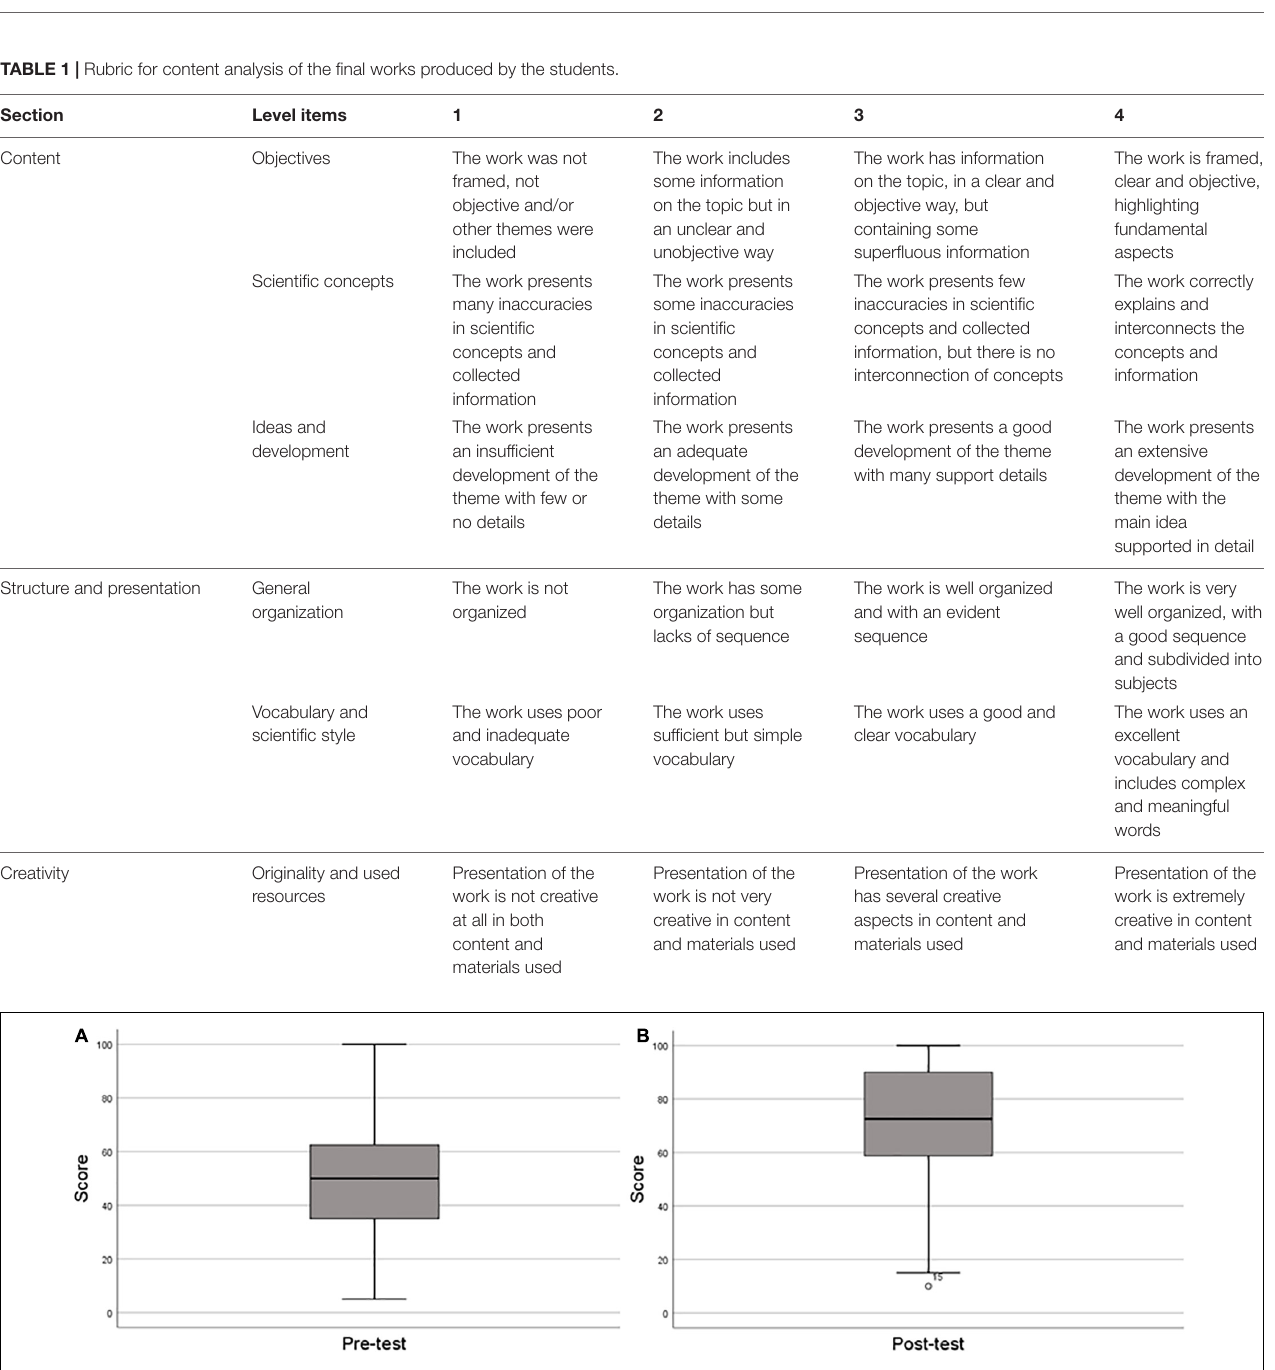
FIGURE 2 | Total scores for pre-test (A) and post-test (B) . Middle line – median; box lower and upper limits – 1st and 3rd quantiles; points –